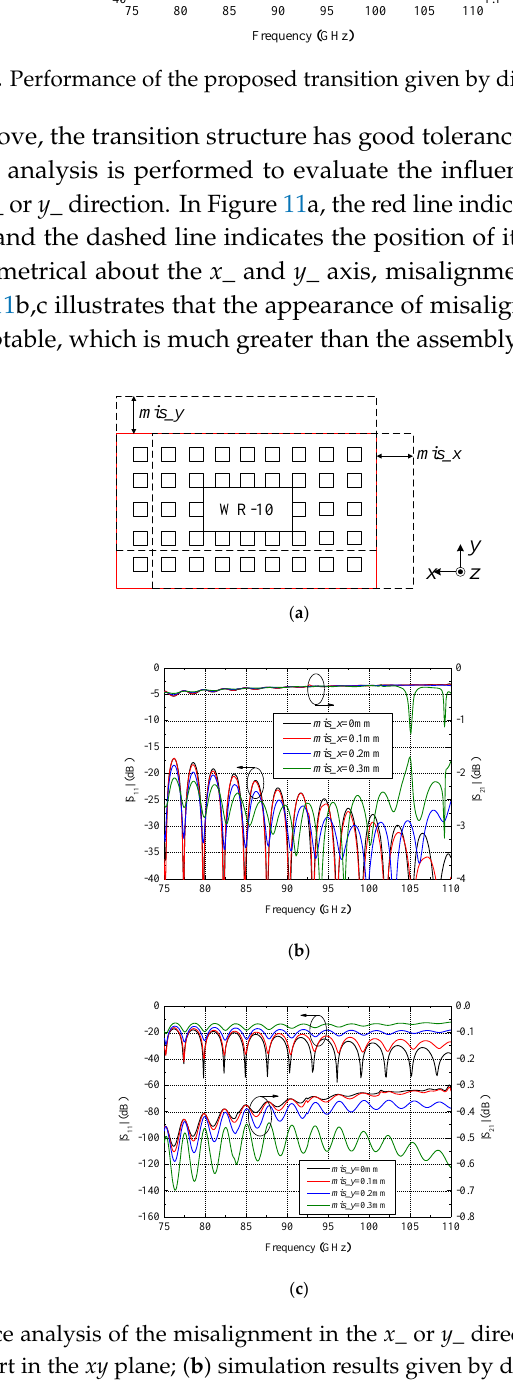
Figure 10. Performance of the proposed transition given by different values of h 1 .